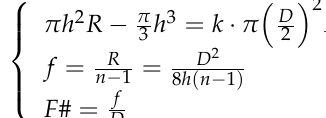
Figure 1. Focusing ability of the MLLAs.